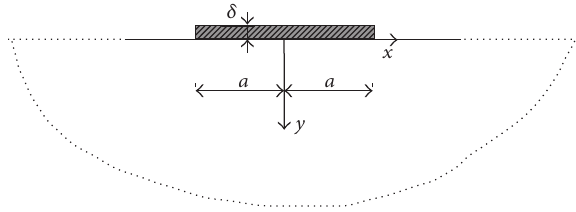
Figure 1: Half plane and film’s